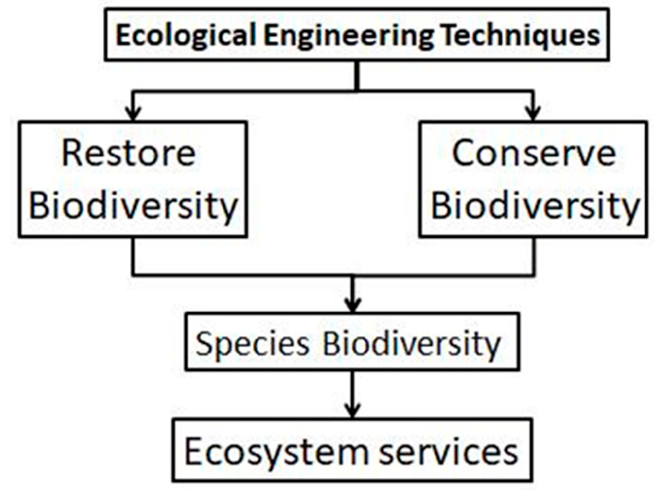
Figure 1. Ecological engineering techniques both restore and conserve biodiversity and ecosystem services.